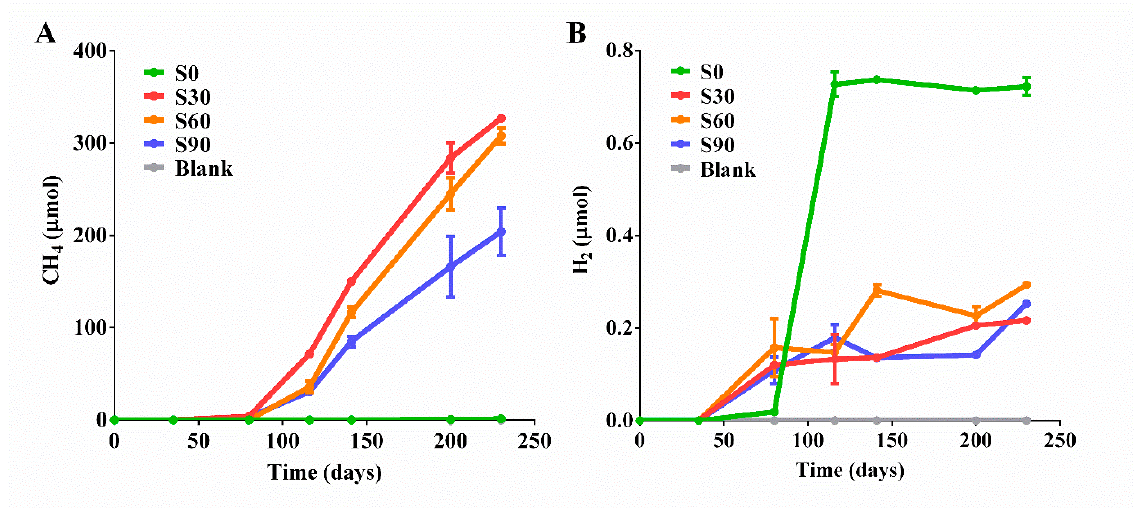
Figure 1. Gas compositions (CH 4 and H 2 ) in the headspace of enrichment under different treatments during the entire incubation time. ( A ) CH 4 production in serum bottle maintained under anaerobic conditions; ( B ) H 2 production in serum bottle maintained under anaerobic conditions.